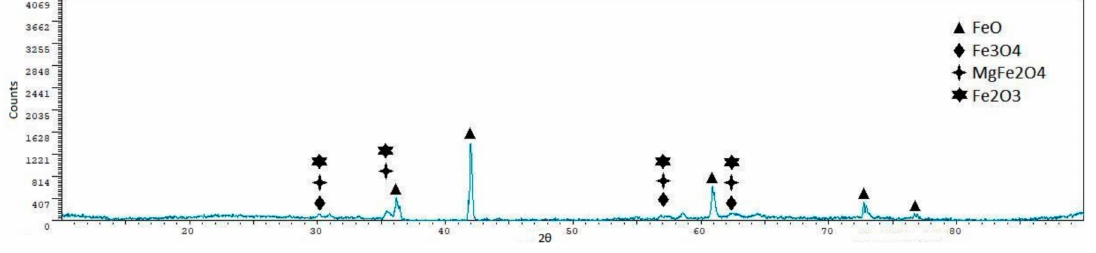
Figure 19. X-ray diffraction pattern for the sample BF1.